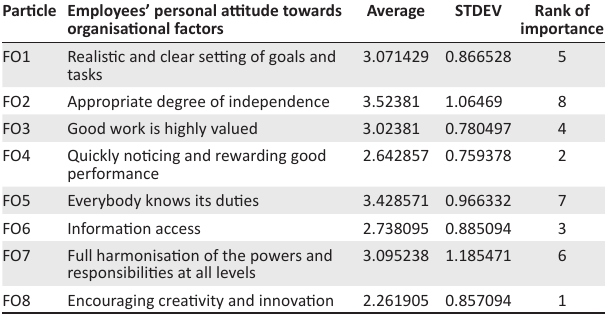
TABLE 10: Presence of organisational climate factors in the